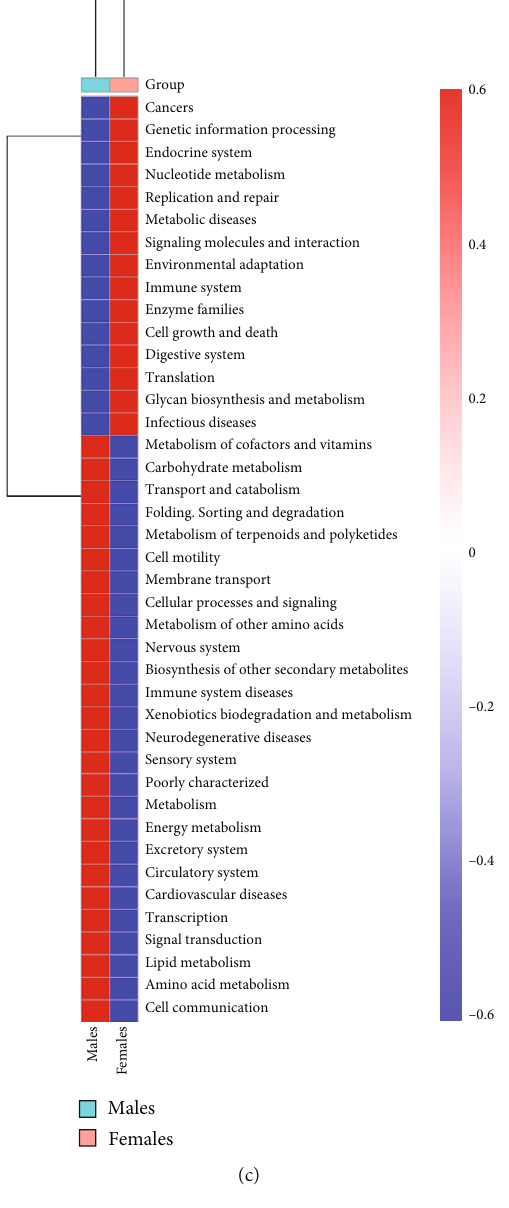
Figure 6: Pathway enrichment analysis based on KEGG. (a) Heat maps of di ff erential pathways at the phylum level and the class level of KEGG in individual patients. (c) Heat map of di ff erential pathways between males and females at the phylum level of